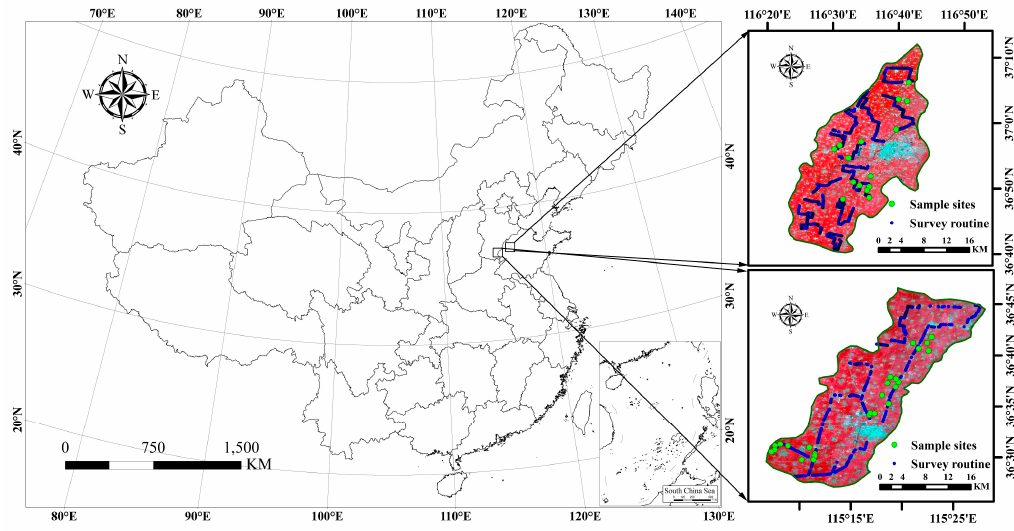
Figure 1. The location map of the study areas in Shandong and Hebei, China (false color composite GF-1 images acquired on 15 and 20 August 2014, R/G/B vs. band 4/band 3/band